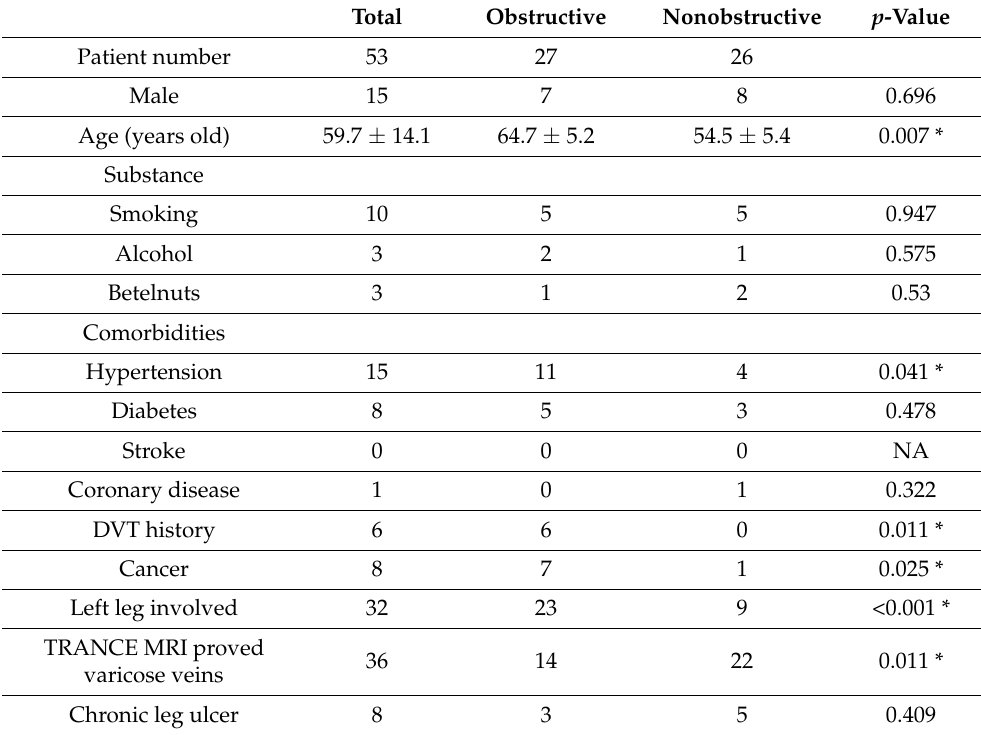
Table 1. Demographic data of 53 patients of a QFlow analysis by TRANCE